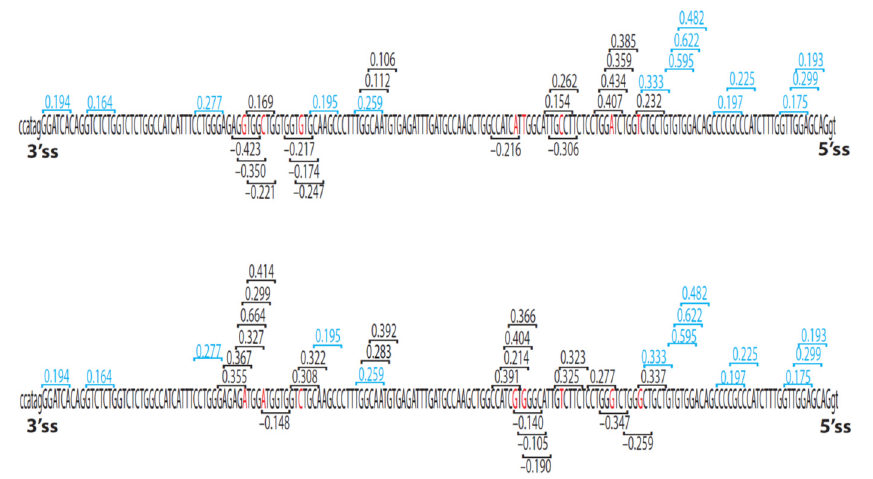
Figure 5. Map showing quantitative effects of hexamers as exonic splicing elements. The upper and lower sequences are for OPN1LW / OPN1MW exon 3, including the locations of the 5 ′ and 3 ′ splice sites (5 ′ ss and 3 ′ ss, respectively). The letters in red font show the common SNPs at each of the eight exon 3 SNPs and, from left to right, correspond to cDNA positions c.453, c.457, c.465, c.511, c.513, c.521, c.528, and c.532. The numbers in blue indicate hexamers that are not affected by the SNPs; the numbers in black change depending on the variant SNPs (upper vs. lower map). Positive values are ESEs; negative values are ESSs. The larger the absolute value of the number, the greater the effect on splicing. The values indicating the impact of each hexamer on splicing are from reference [82].